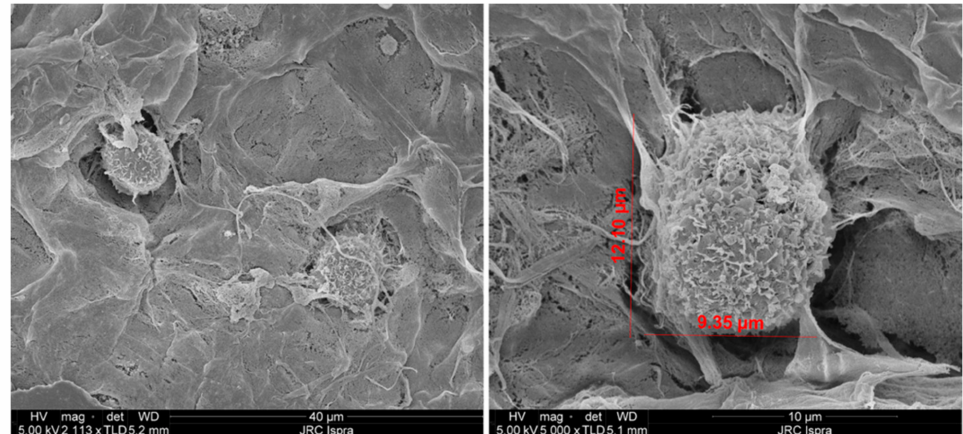
Figure 5. ASC appearance on the NFC / A 3D sca ff old surface seeded with 6.0 × 10 6 ASCs / mL and culture for 14 days. Micrographs obtained by SEM showing the interaction of ASCs by cytoskeleton filaments with the surrounding enabling cell–cell